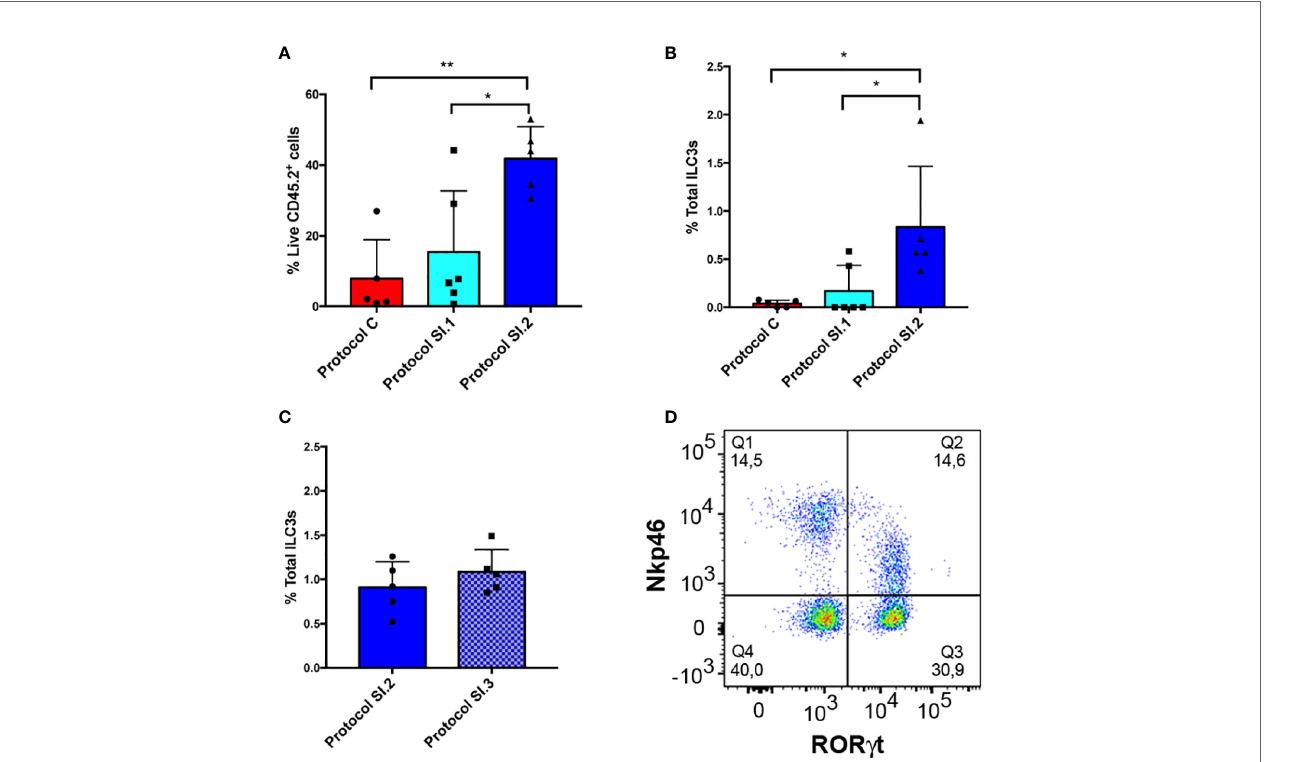
FIGURE 6 | Small intestine ILC3 yield with the different protocols. (A) CD45 + live LPC yield compared among 3 different protocols. Protocol C corresponds to the LPC isolation used for the colon. Protocol SI.1 corresponds to the LPC isolation protocol used for the small intestine without considering the critical step of scraping and rolling of the small intestine. Protocol SI.2 corresponds to the protocol for the small intestine including the critical step involving thorough cleaning of the fat residue. (B) Comparison between the different ILC3 yields of the 3 protocols described in A. (C) ILC3 yield comparing protocol SI.2 with a conventional protocol based on type IV collagenase and 40 – 70% percoll gradient (protocol SI.3). (D) Representative dot plot of ROR g t and Nkp46 staining of LPCs from small intestine gated on negative lineage, live CD45.2 + cells. Data correspond to the arithmetic mean and SD (1-way ANOVA and Bonferroni multiple comparisons test). **P < 0,005; *P < 0,05. LPCs, lamina propria